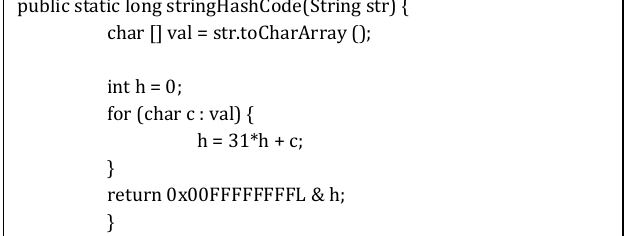
Fig. 2. X31 hash in Java